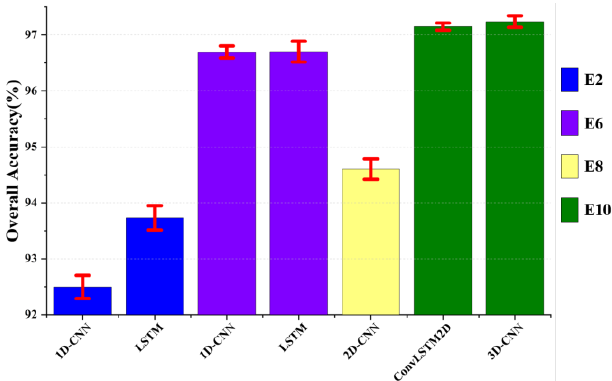
Figure 9. The OA of different deep learning